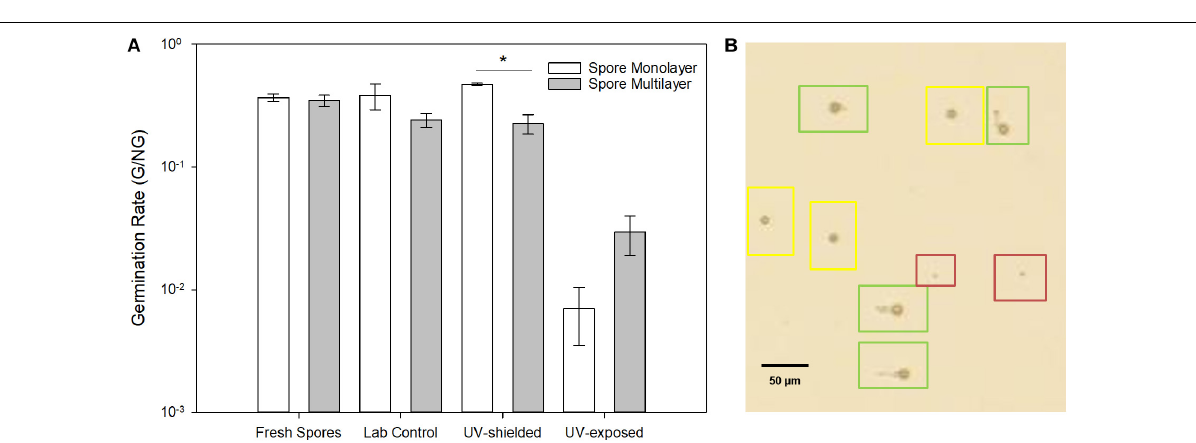
FIGURE 8 | (A) Germination rate (G/NG) of A. niger spores after exposure to simulated Mars conditions. (B) Light microscopy showing resting spores (red), swollen spores (yellow) and germinated spores (green). Both resting and swollen spores were counted as